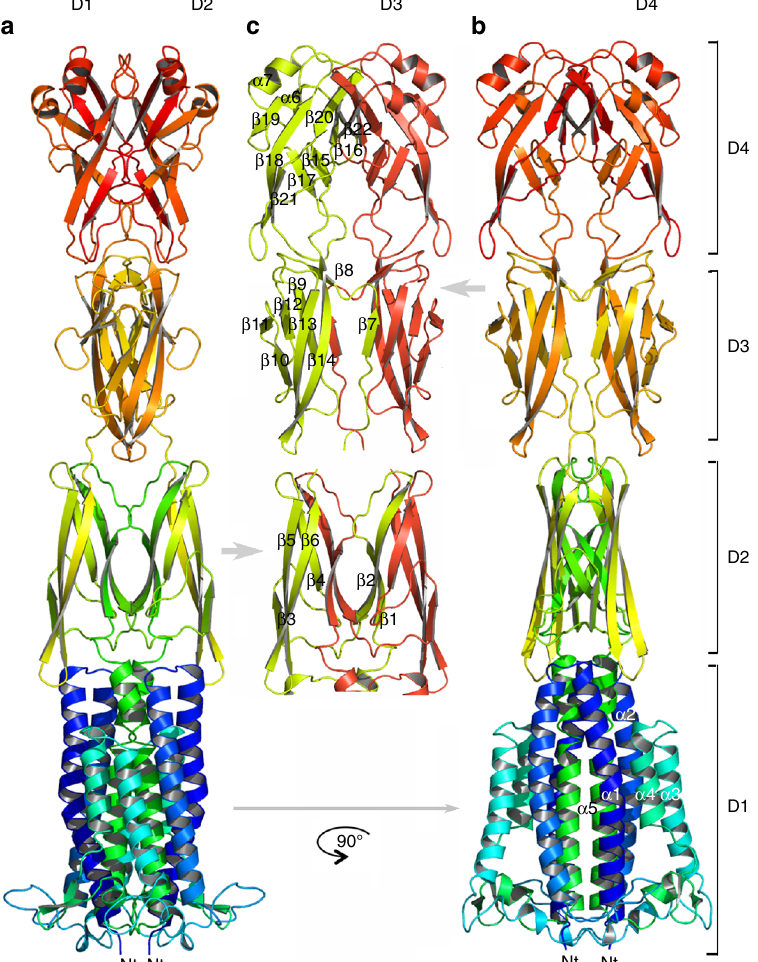
Fig. 1 Crystal structure of GldMp from Flavobacterium johnsoniae . a Ribbon view of the GldMp structure rainbow colored from the N-terminus (blue) to the C terminus (red). b The same representation, 90° from a . The four domains are labeled D1, D2, D3, and D4. c Domains are colored by polypeptide chain, yellow and red. Note the swapped β -strands in domains D2 ( β 1 and β 2) and D3 ( β 7). Top, the secondary structure